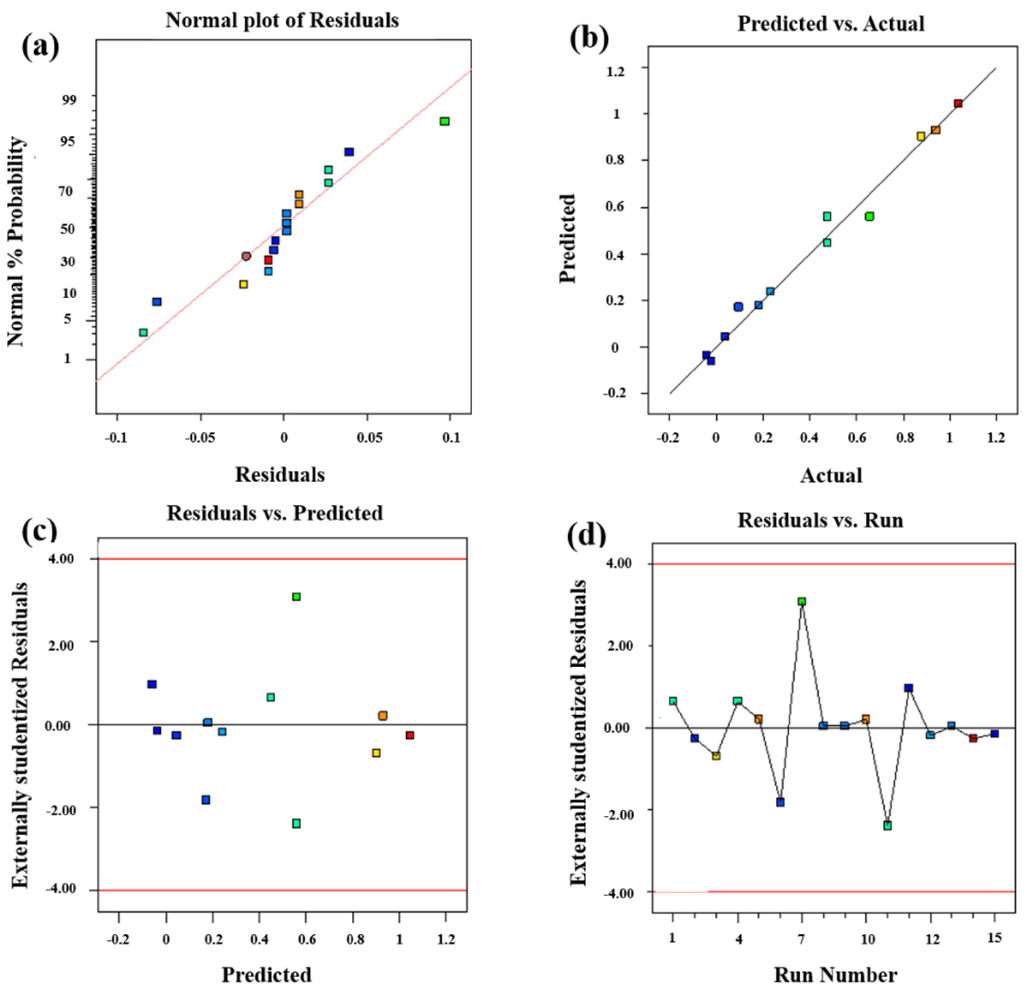
Figure 9. ( a ) Normal plot of residuals ( b ) predicted vs. actual plot ( c ) residuals vs. predicted plot ( d ) residuals vs. run plot.